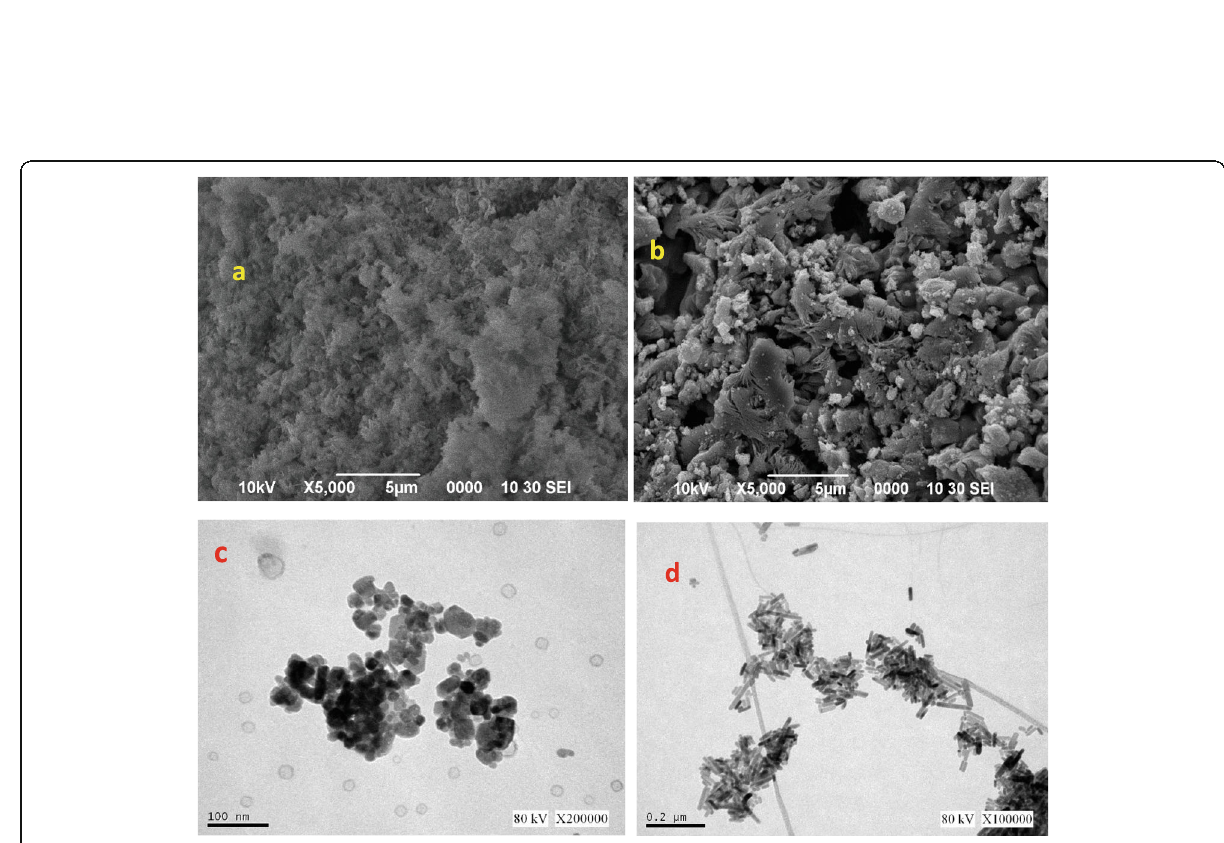
Fig. 2 SEM images of ZnO NPs of a ZnAc and b ZnCl 2 , and TEM images of c ZnAc and d ZnCl 2 from aqueous extract of A.